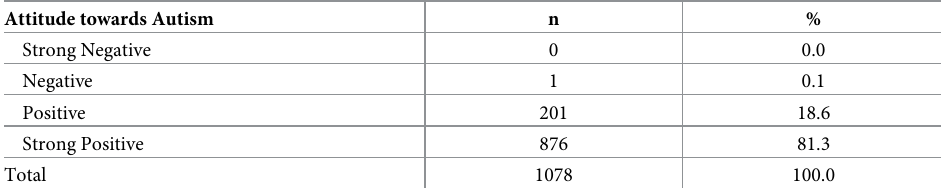
Table 5. Overall attitudes towards